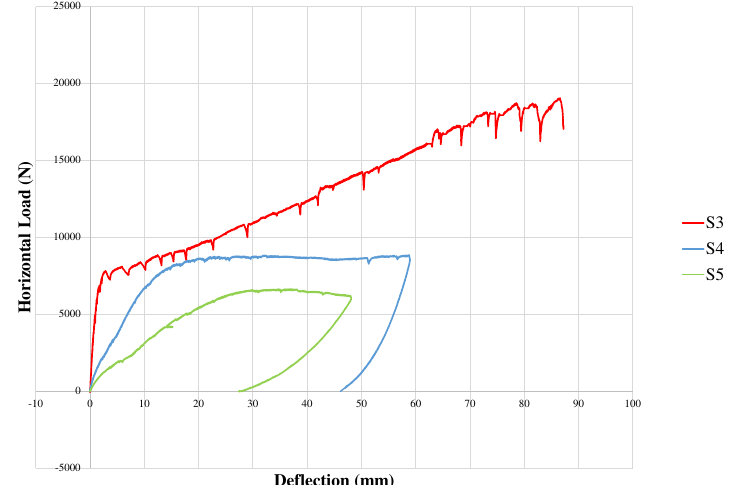
Fig. 6 Load deflection curve for specimens: S3, S4, and